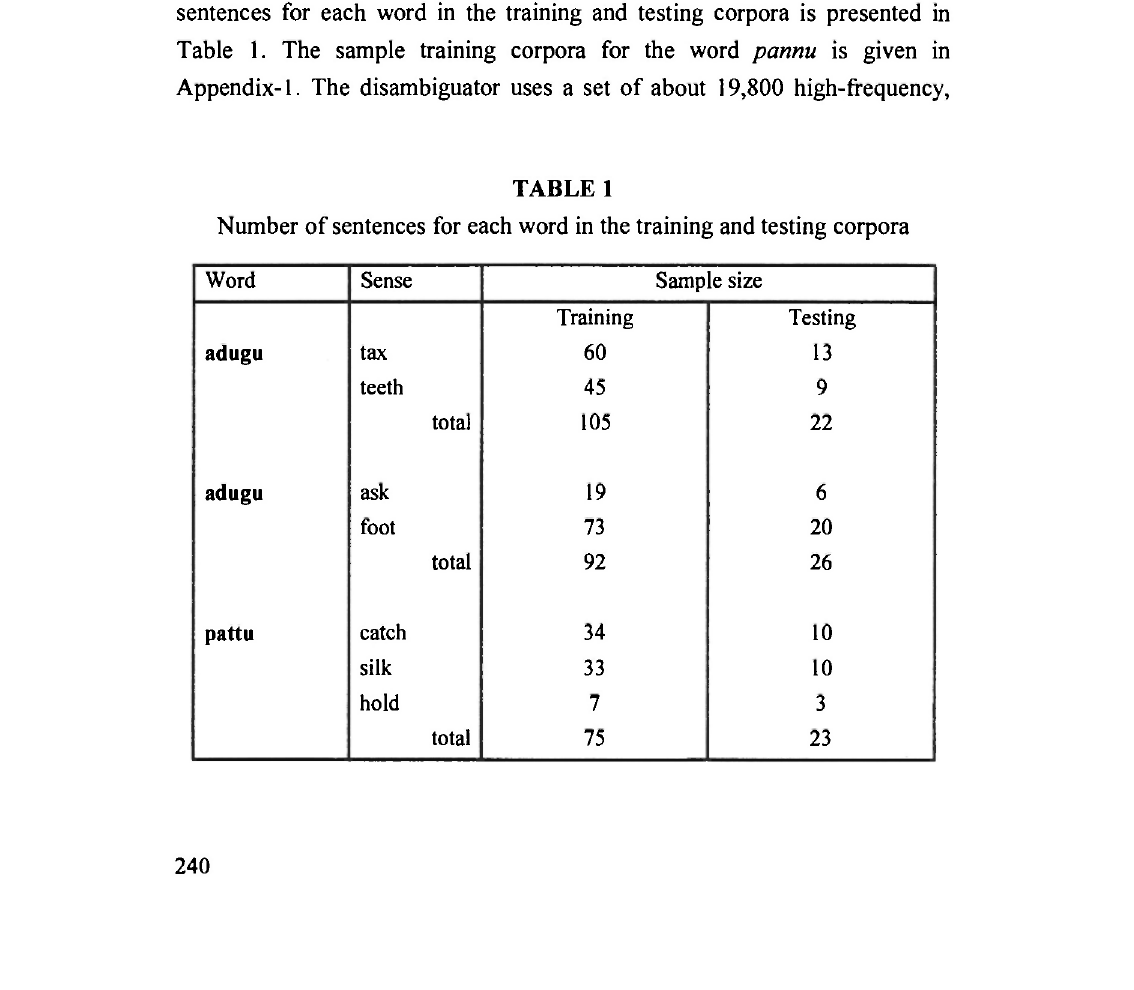
Number of sentences for each word in the training and testing corpora Word Sense Sample size Training Testing adugu